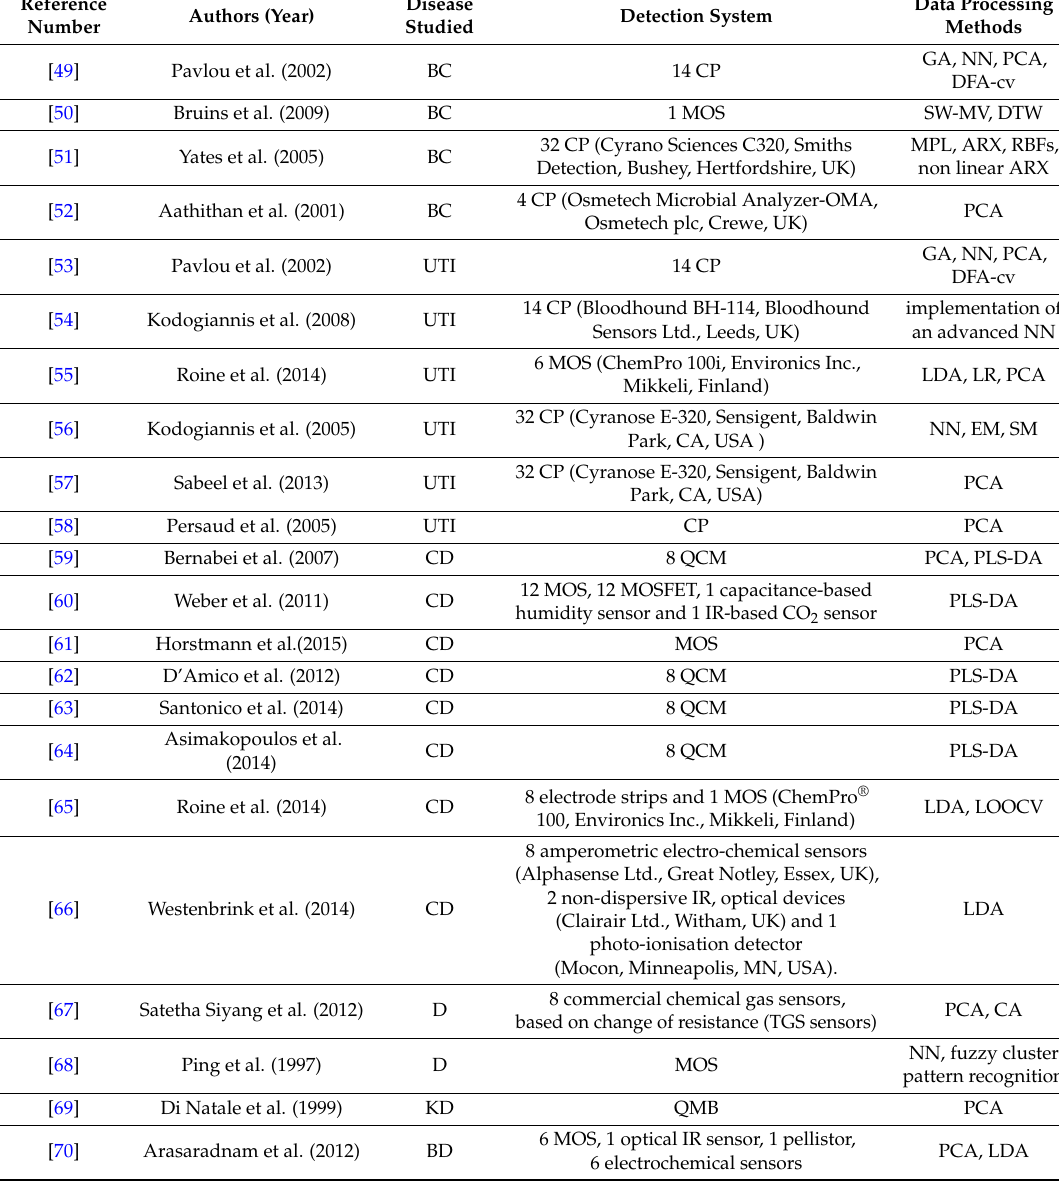
Table 1. Application of e-nose for evaluation of different diseases using urine